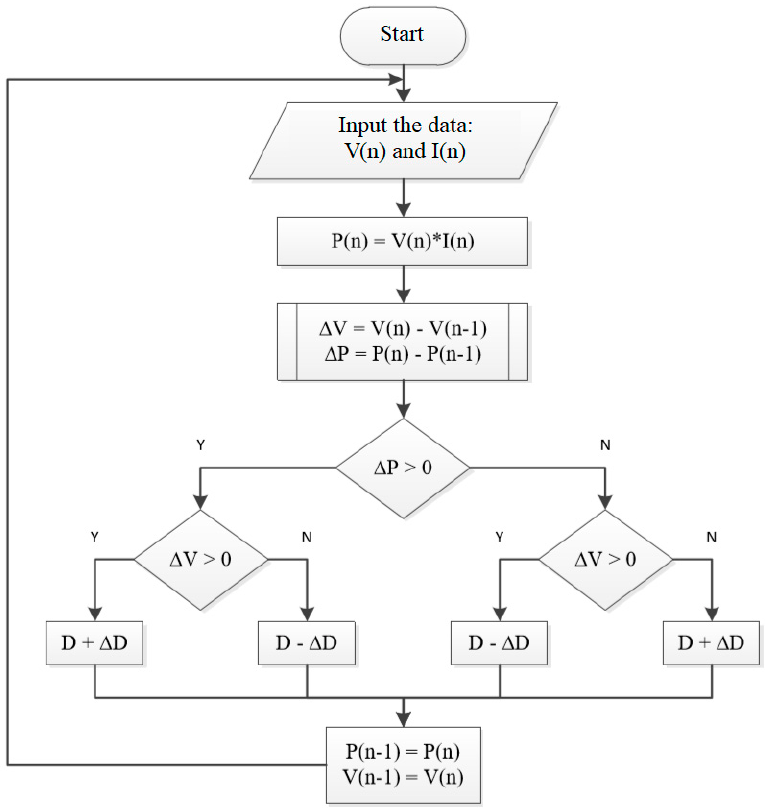
Figure 4. Flow chart of the standard perturb and observe (PO) algorithm.